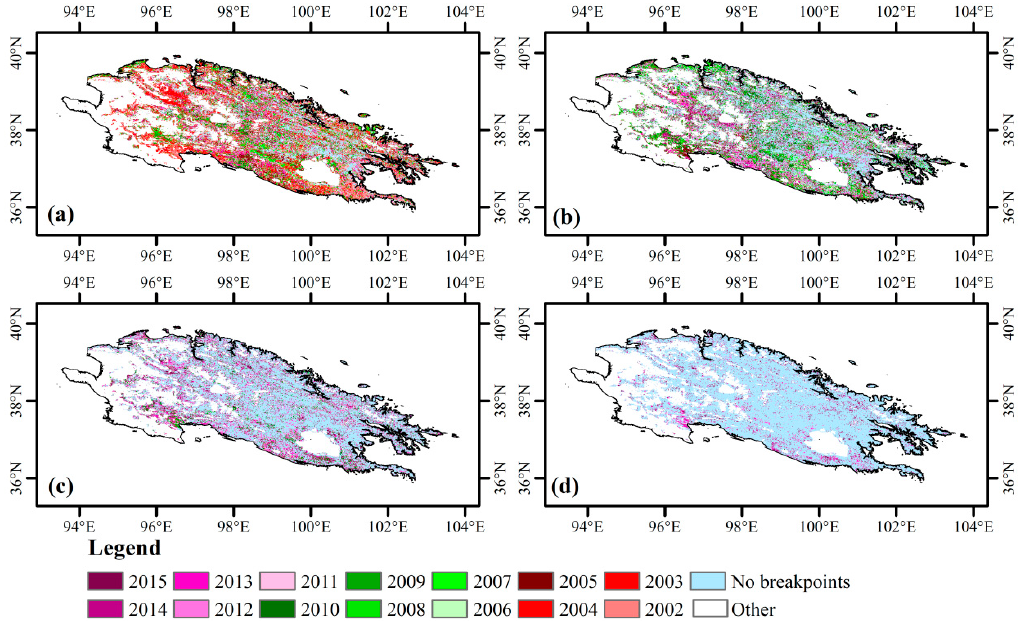
Figure 5. Spatial distributions of the estimated timing of abrupt changes in the trend component in the Qilian Mountains in the period of 2000–2017: ( a ) first abrupt change distribution; ( b ) second abrupt change distribution; ( c ) third abrupt change distribution; and ( d ) fourth abrupt change distribution. Other means no vegetation and managed vegetation area.